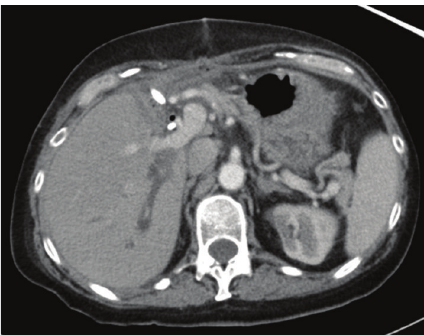
Figure 2: Isolated dilated right posterior sectoral duct. CT scan demonstrating dilated right posterior duct after adequate drainage of the biloma. Note the anterior ductal system is decompressed.